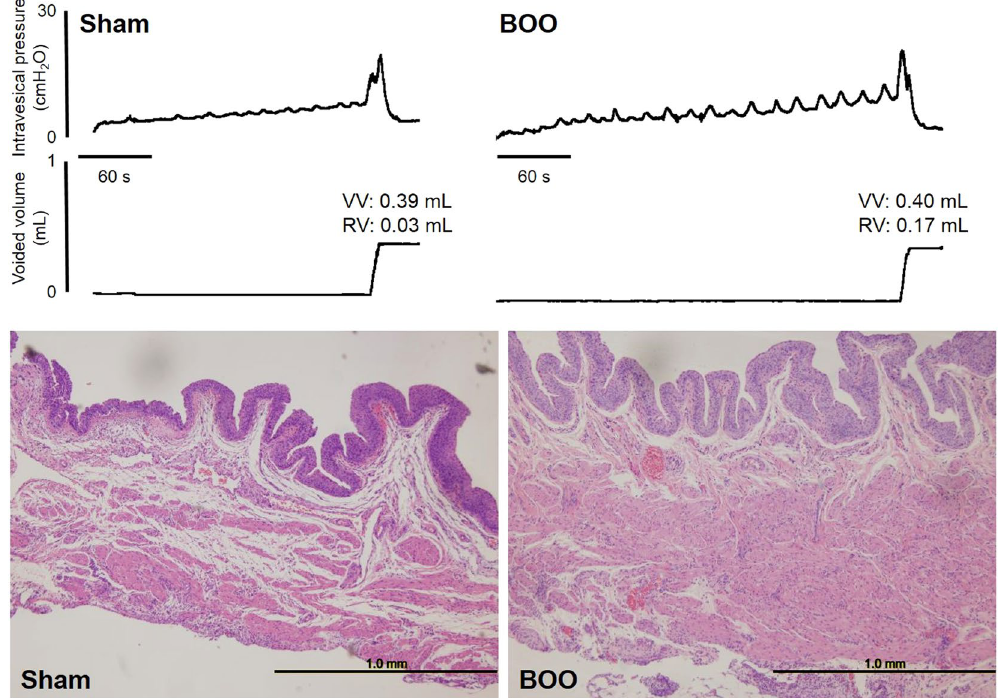
Figure 1. Representative CMG traces (upper traces) and microscopic images with HE staining of the bladder (lower traces) in the Sham and BOO rats at day 4 post-operatively. VV: voided volume, RV: residual